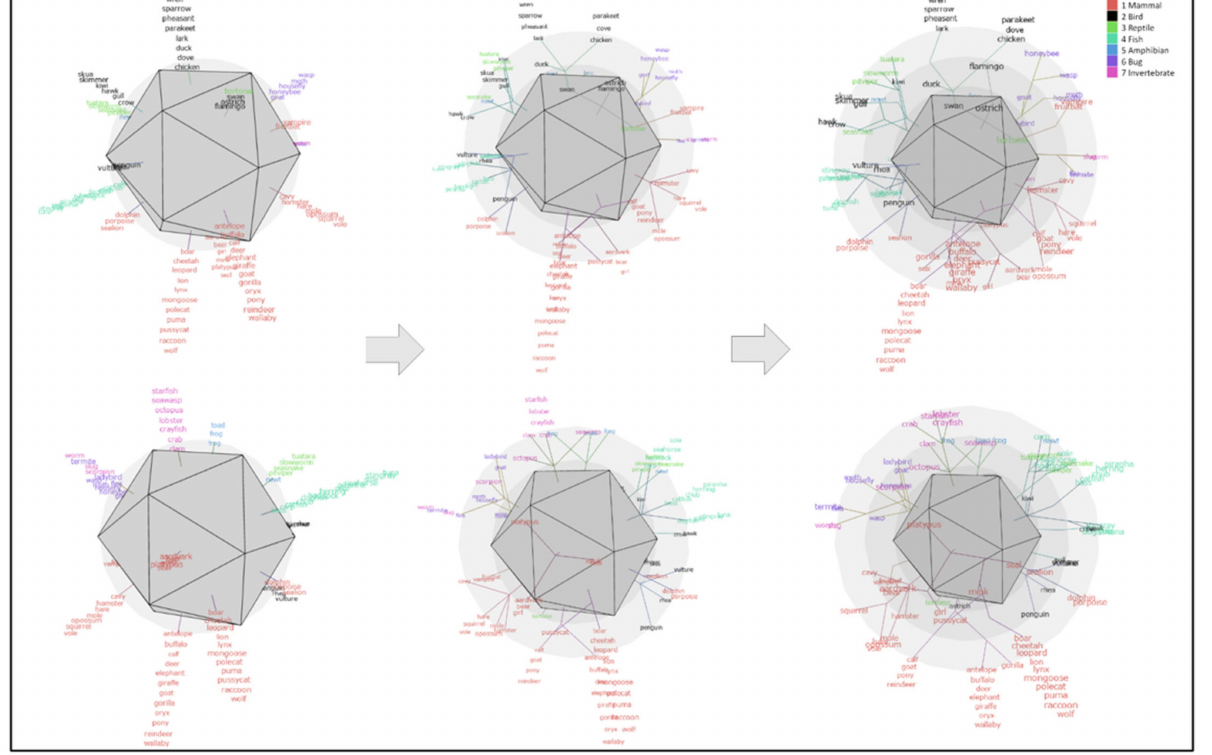
Figure 9. Result of data clustering utilizing the